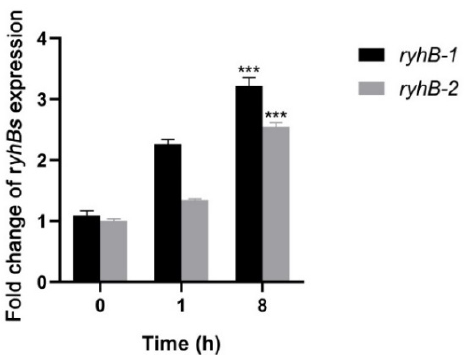
Figure 3. Expressions of RyhB-1 and RyhB-2 from SE50336 infecting HD11 macrophages. Total RNA was extracted at 1 h post-infection (hpi) and 8 hpi, respectively. The relative expressions of RyhB-1 and RyhB-2 were determined using qRT-PCR. The expression values were normalized to the levels of the reference gene gyrA and calculated using the 2 −∆∆ CT method. Values in y -axis mean quantification values of RyhB-1/RyhB-2 expression at 1 hpi and 8 hpi relative to that at 0 hpi. All assays were performed in triplicate. *** p < 0.001, one-way ANOVA.